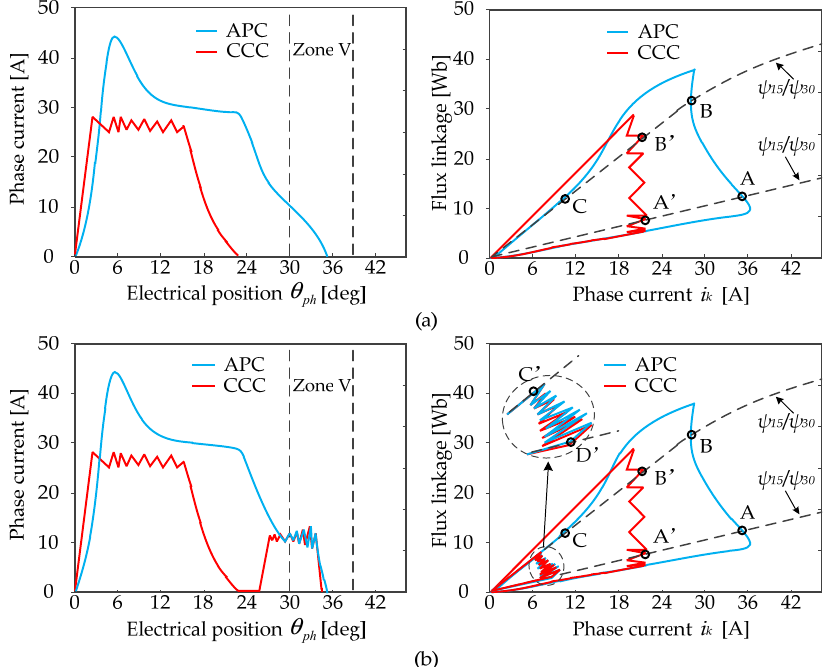
Figure 13. Schematic diagram of the hybrid method based on flux linkage and current waveforms. ( a ). Normal excitation mode. ( b ). excitation mode with chopping.